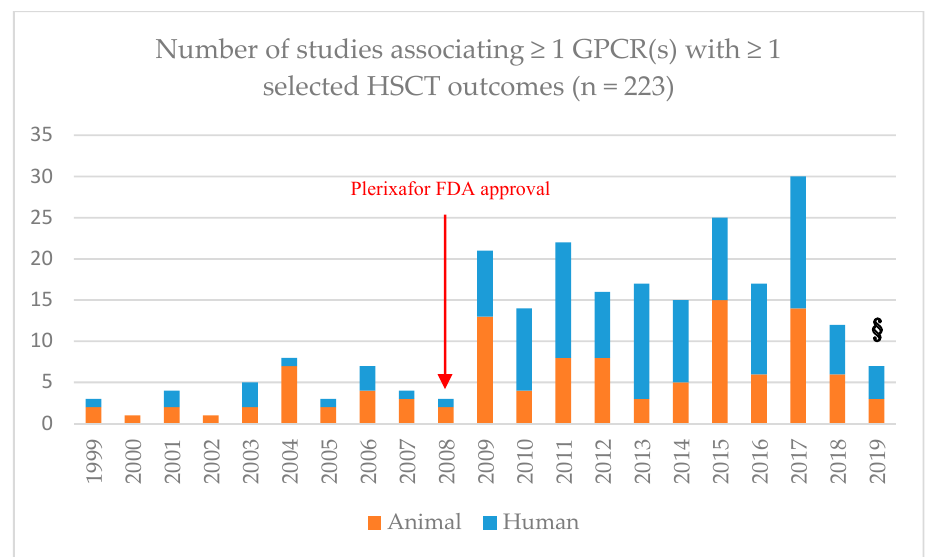
Figure 1. Flow diagram displaying the number of records identified, included, and excluded via a systematized literature review following Preferred Reporting Items for Systematic Reviews and Meta- Analyses (PRISMA) guidelines [300]#.